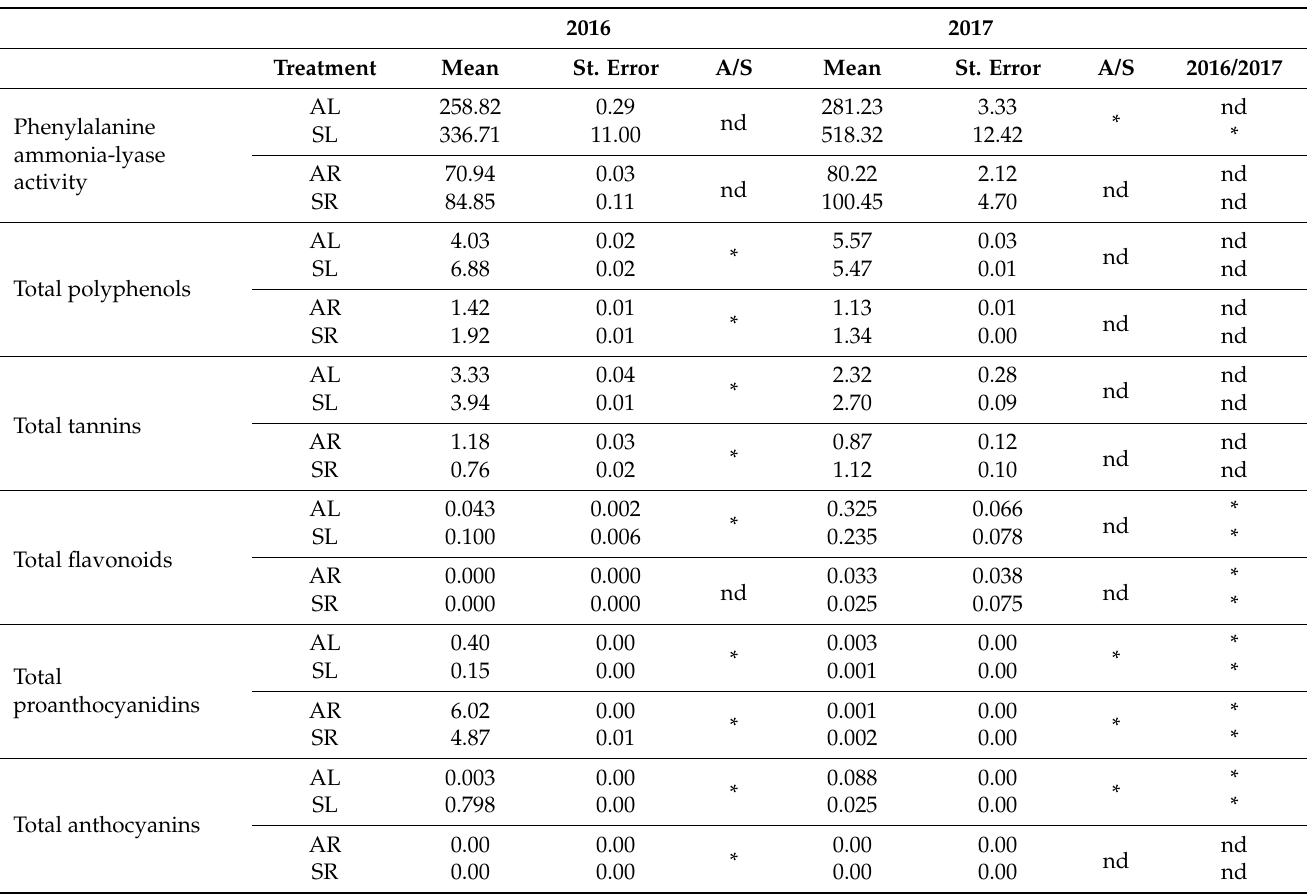
Table 3. Phenylalanine ammonia-lyase (U/g fw) and polyphenolic compounds content (mg/g dw) in asymptomatic (A) and symptomatic (S) carrot leaves (L) and roots